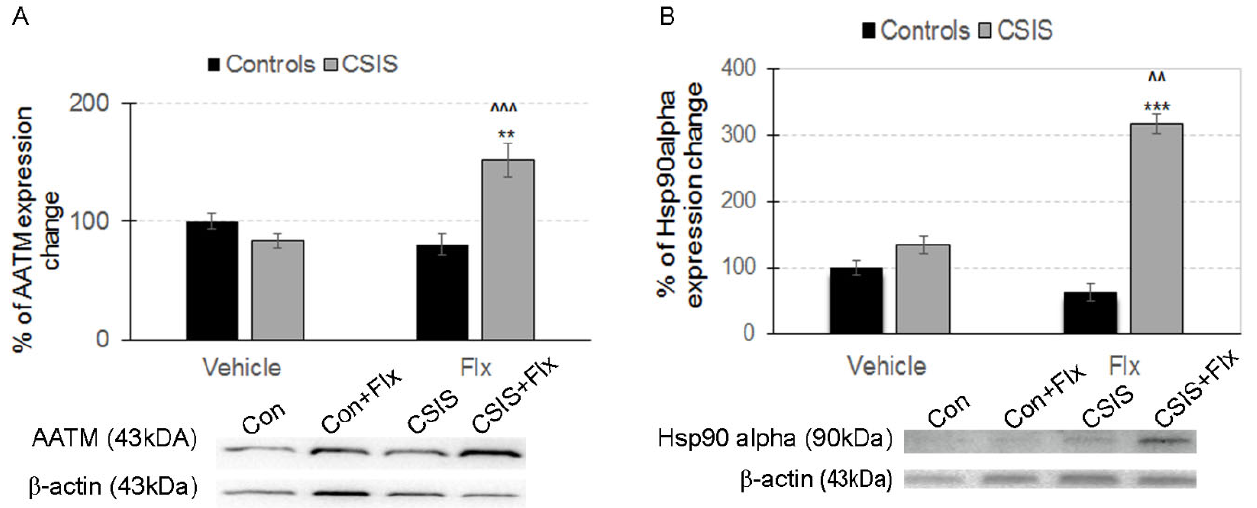
Figure 3. Validation of selected differentially expressed proteins in synaptosomal-enriched fractions of the rat hippocampus from Controls + Vehicle (Con), Controls + Fluoxetine (Con + Flx), Chronic Social Isolation + Vehicle (CSIS), and Chronic Social Isolation + Fluoxetine (CSIS + Flx) groups. Data are represented as % of protein expression change ± standard error of the mean (SEM), n = 3–6 rats per each group. Significant differences between groups obtained using a two-way ANOVA followed by Duncan’s post hoc test are indicated as follows: ( A ) aspartate aminotransferase, mitochondrial (AATM)–CSIS + Flx vs. CSIS ( ˆˆˆ p < 0.001) and CSIS + Flx vs. Con (** p < 0.01); ( B ) heat shock protein 90 alpha (Hsp90 alpha)–CSIS + Flx vs. CSIS ( ˆˆ p < 0.01) and CSIS + Flx vs. Con (*** p <